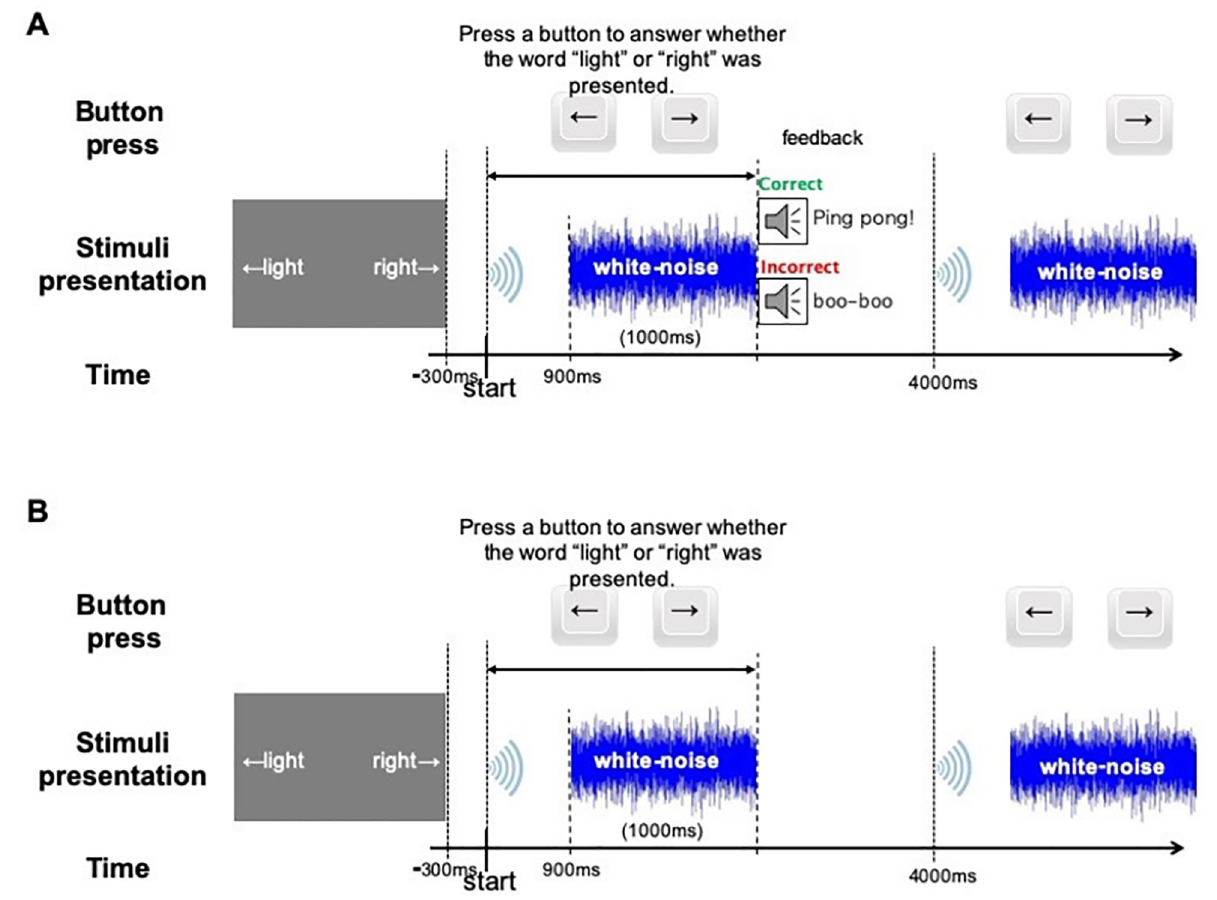
Fig 3. Schematic drawing of behavioral training with feedback (A) and without feedback (B).